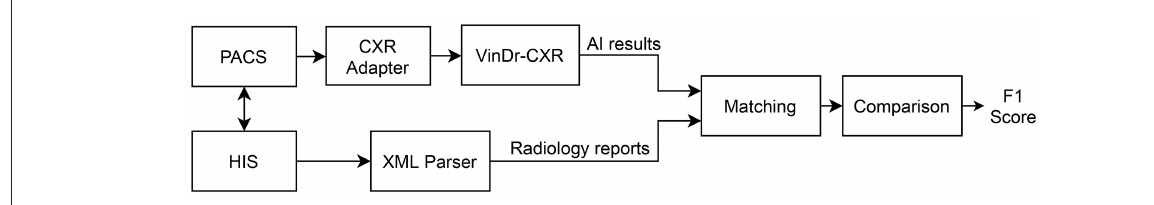
FIGURE1 Validation scheme. PACS and HIS are linked by Patient ID.